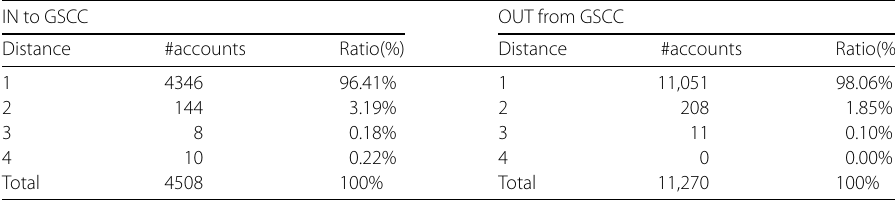
Figure 7 Walnut structure: a schematic view. The so-called bowtie structure reveals that GSCC includes nearly 40% of all the nodes or accounts, while the IN and OUT components include 15% and 37%, respectively (see Table 4 for the details). The prominent features are as follows. (i) The shortest distances to IN and OUT from GSCC are quite small, typically 1 or 2, and 4 at most (Table 5); hence, the ties are not elongated like a “bowtie” but rather like a “walnut” skin. (ii) The nodes in the components of IN and OUT are connected to the nodes scattered widely in GSCC. See also the study of a supplier-customer network [11] with similar features